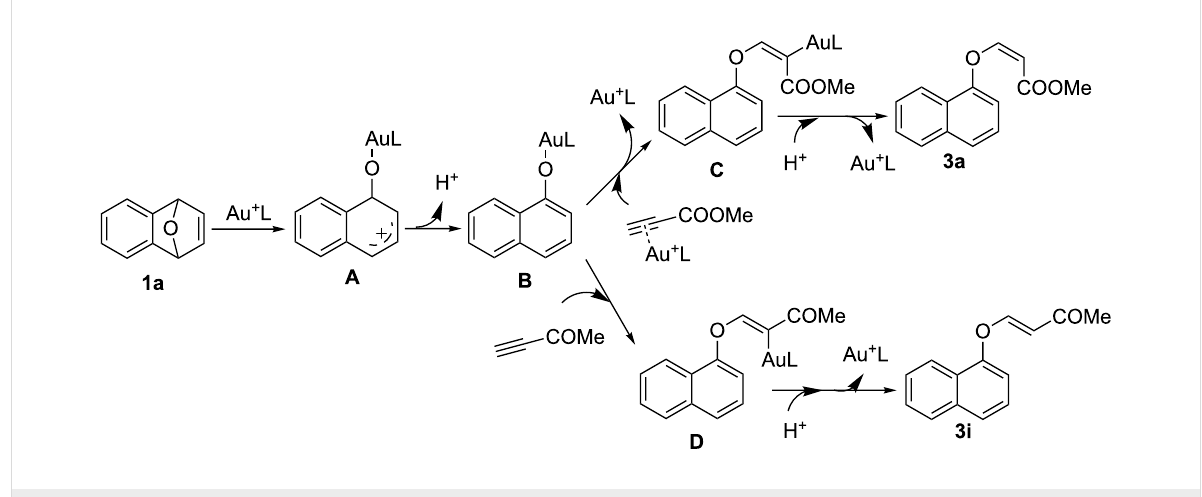
chromatography (TLC), silica gel plates (Huanghai GF254) were used. Mass spectra were recorded by ESI, and HRMS were measured on a HP-5989